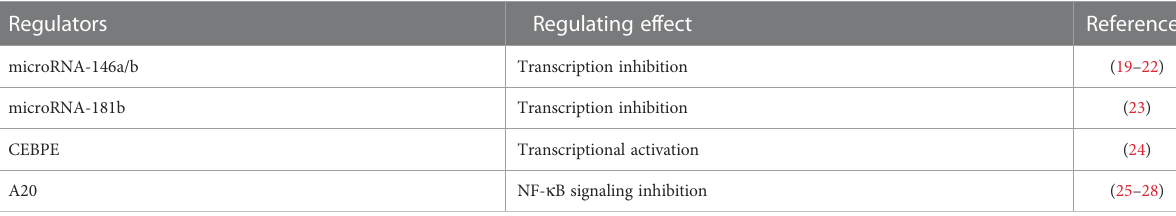
TABLE 1 List of CARMA3 regulators.